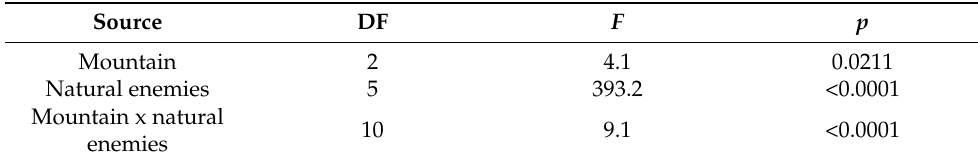
Table 4. ANOVA parameters of main effects and associated interaction for the activity of natural